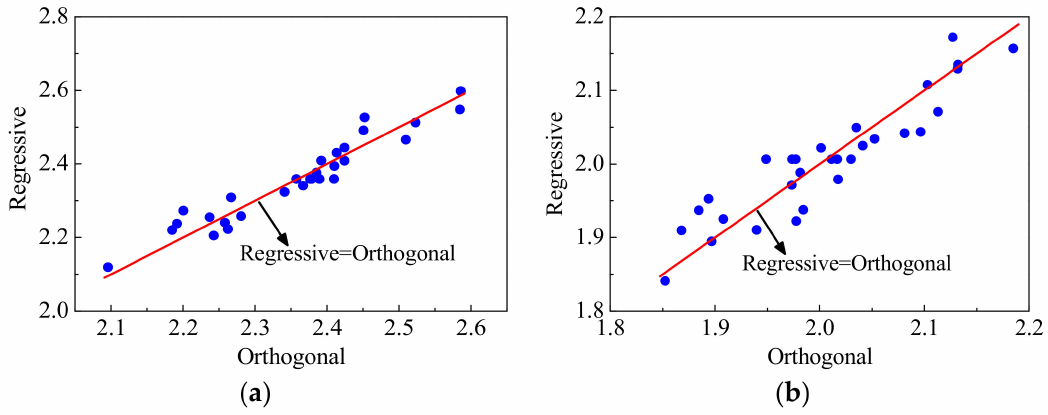
Figure 12. Comparisons of the design DVCs obtained via regression and orthogonal calculations: ( a ) design DVC of displacement; ( b ) design DVC of internal force.